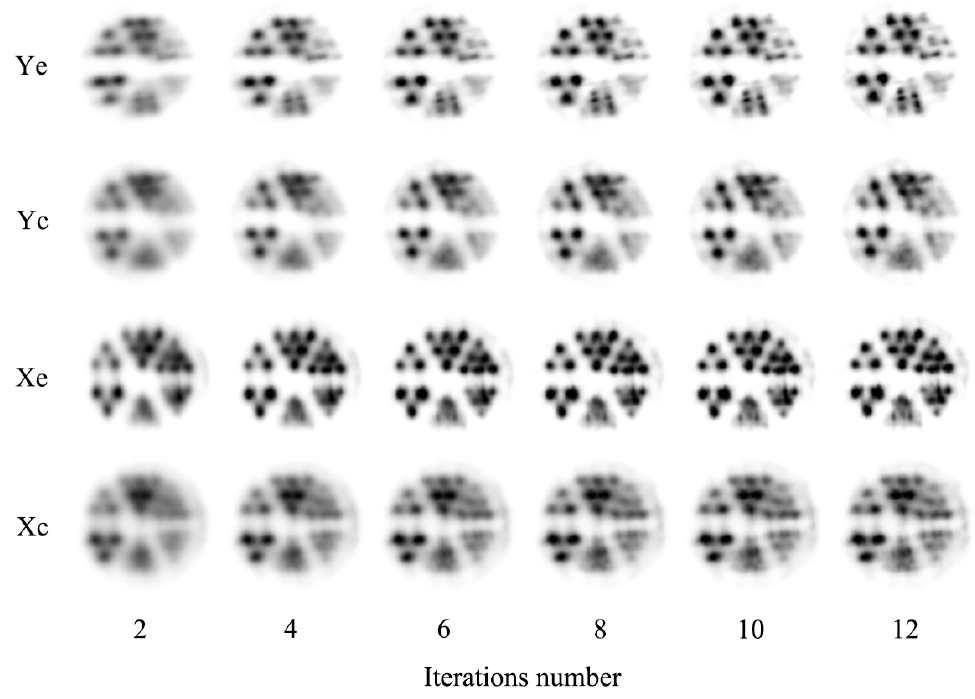
Figure 6. The PET images of the Derenzo phantom reconstructed by the 3D-OSEM algorithm (5 subsets, 20 iterations) in different orientations and positions, and at different iteration numbers.